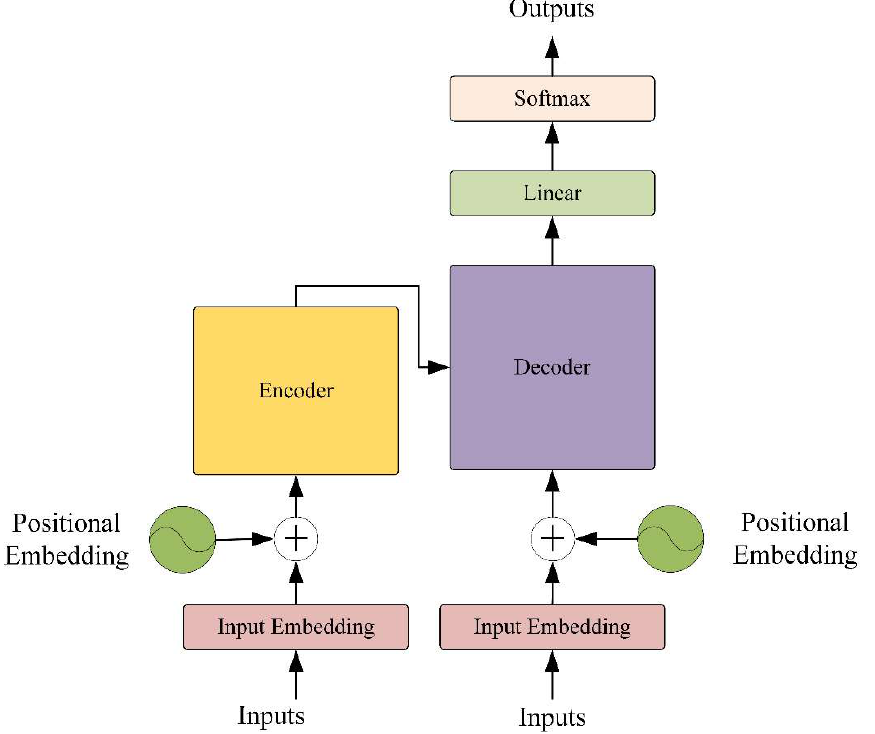
Figure 3. The architecture of the transformer.